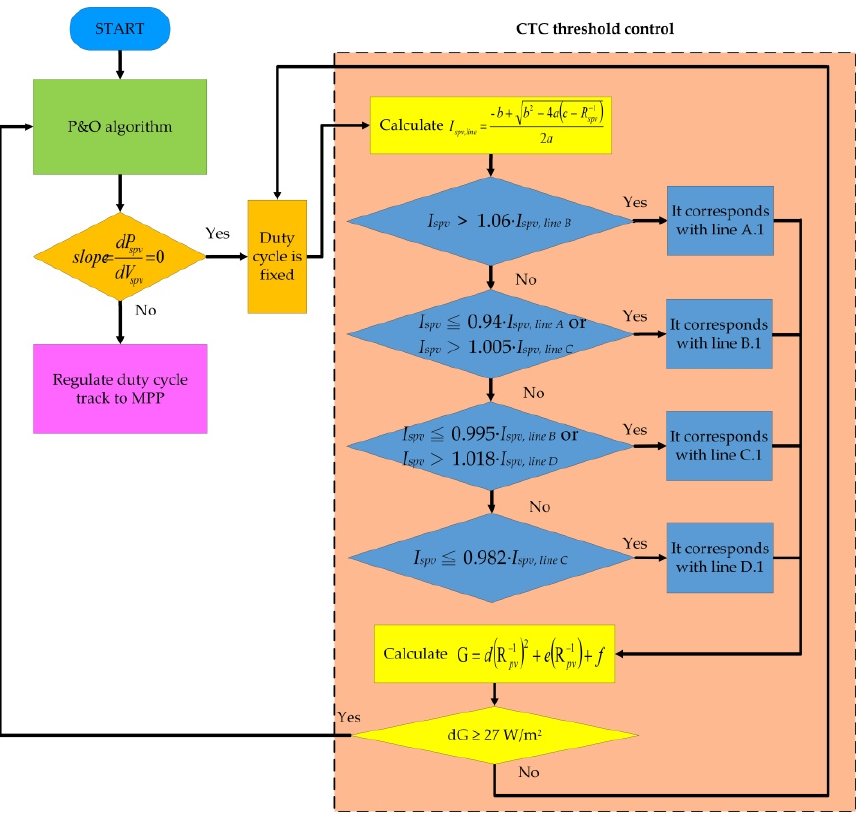
Figure 5. The proposed algorithm flowchart.